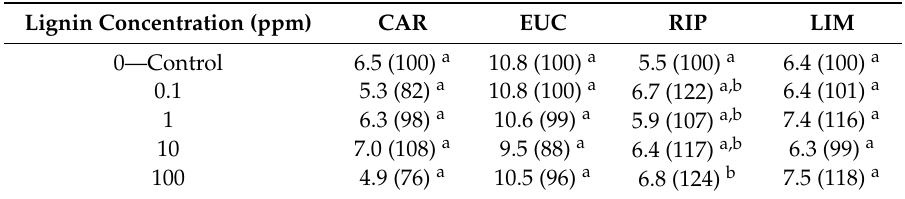
Table 3. Length (cm) of radicle roots for maize seedlings treated with different concentrations (ppm) of CAR, EUC, RIP and LIM water-soluble lignins. Lignin Concentration (ppm)